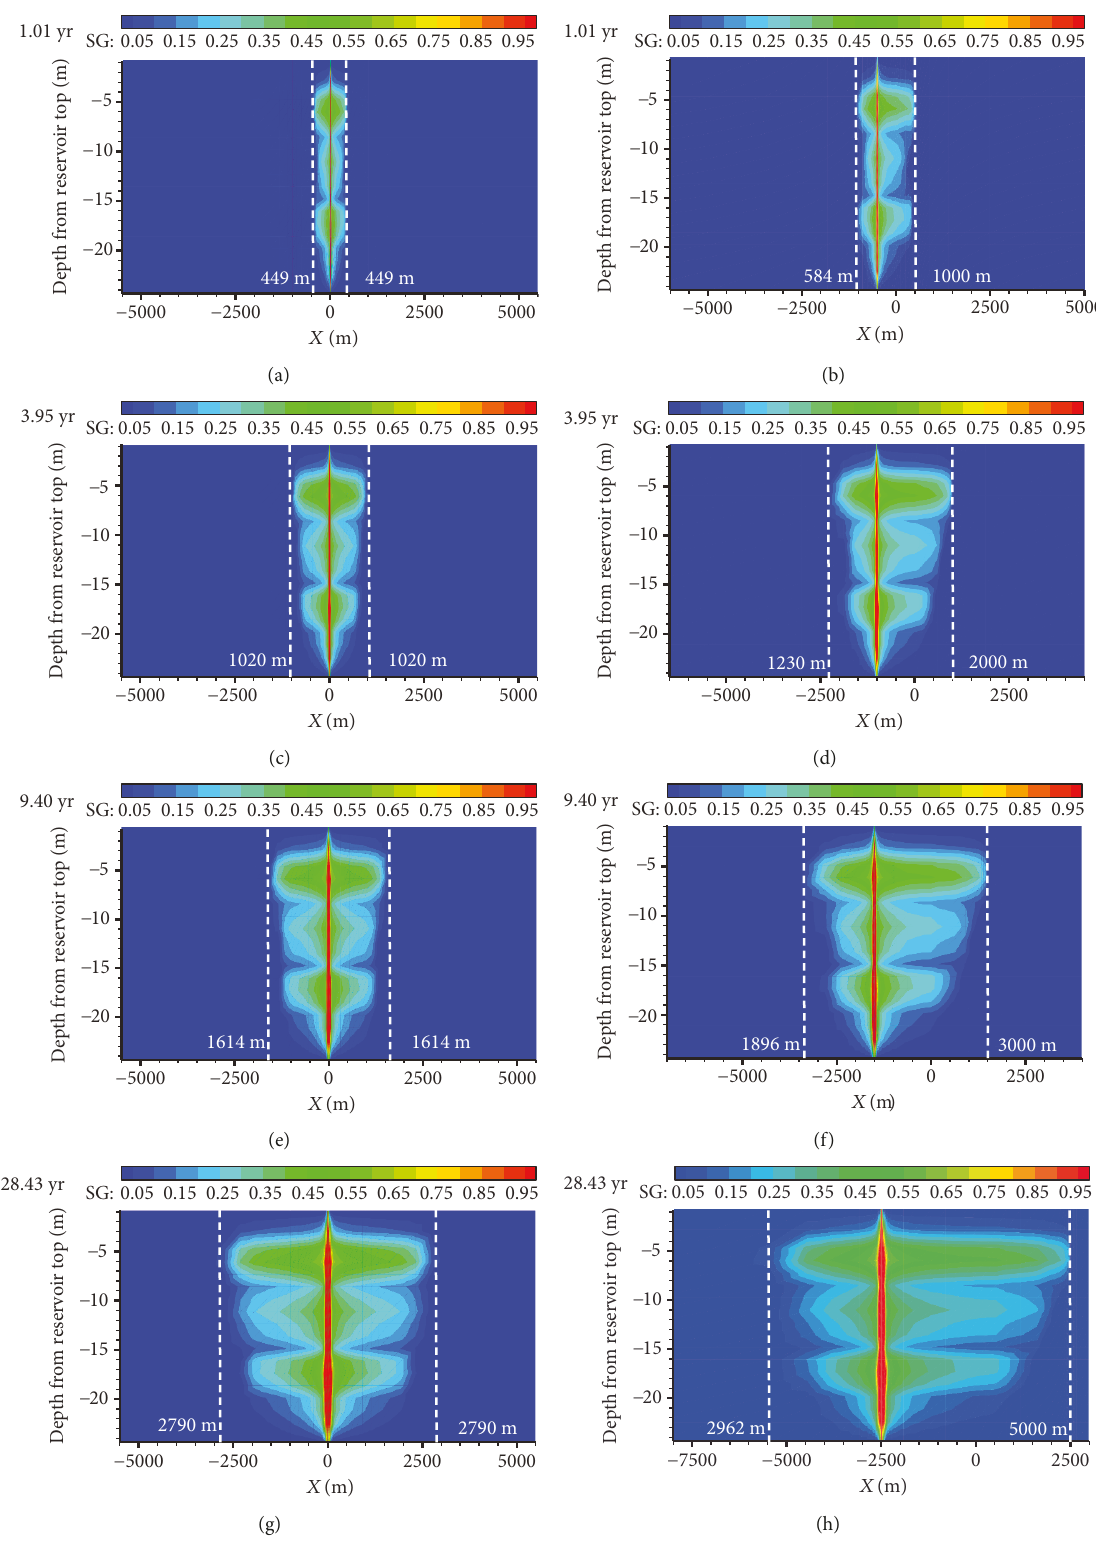
Figure 6: Spatial distribution of the supercritical CO CO injection at 1.01 years. (b) The well spacing of 1km at 1.01 years. (c) Sole CO 2 years. (e) Sole CO injection at 9.40 years. (f) The well spacing of 3km at 9.40 years. (g) Sole CO 2 of 5 km at 28.43